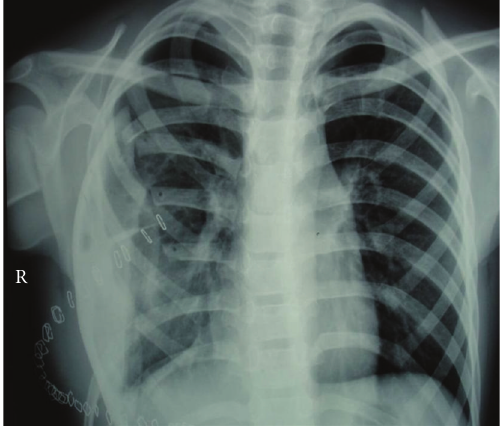
Figure 5: Chest X ray postsurgery in Case